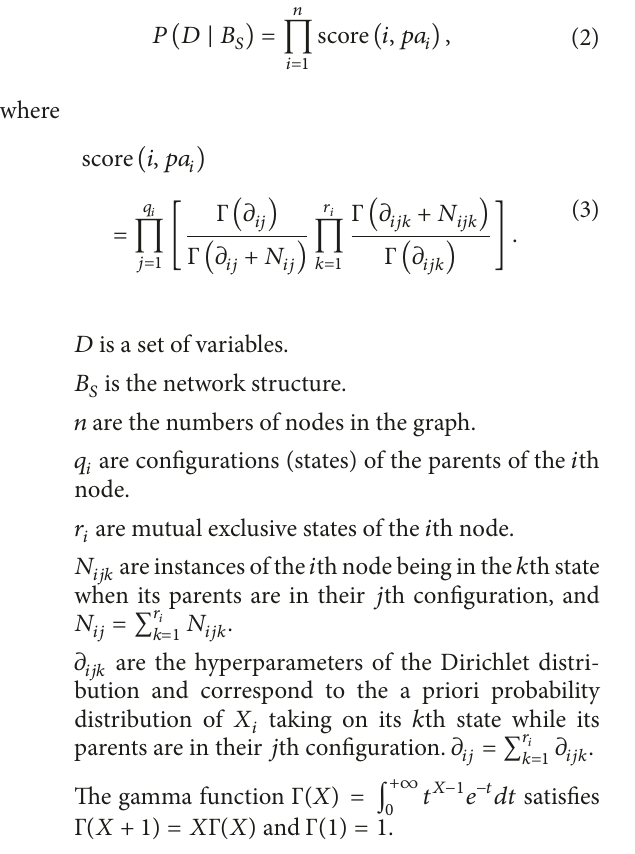
Figure 1: Graph of a valid Bayesian network (no cycle exists).